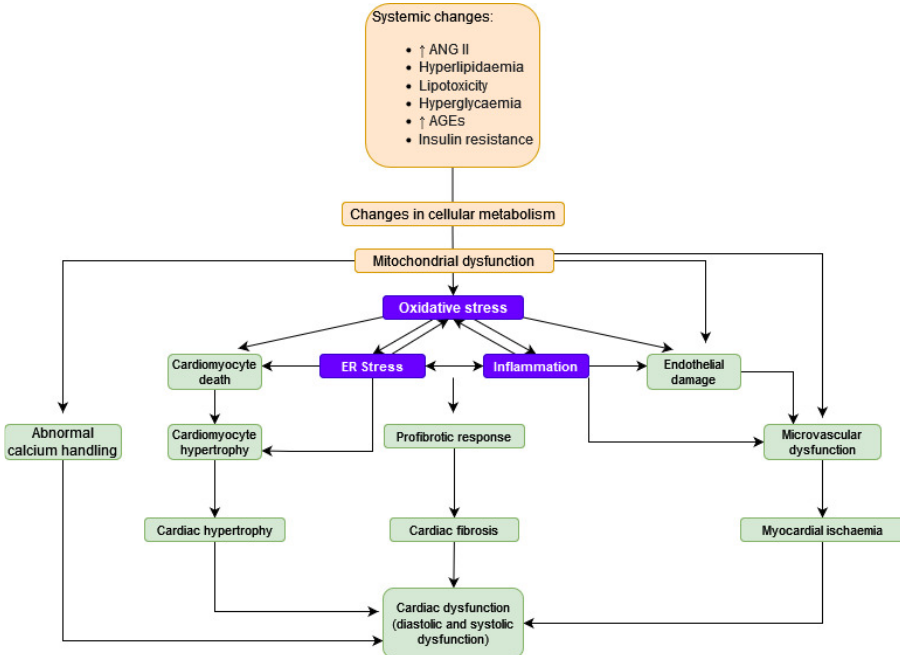
Figure 1. The pathophysiology of